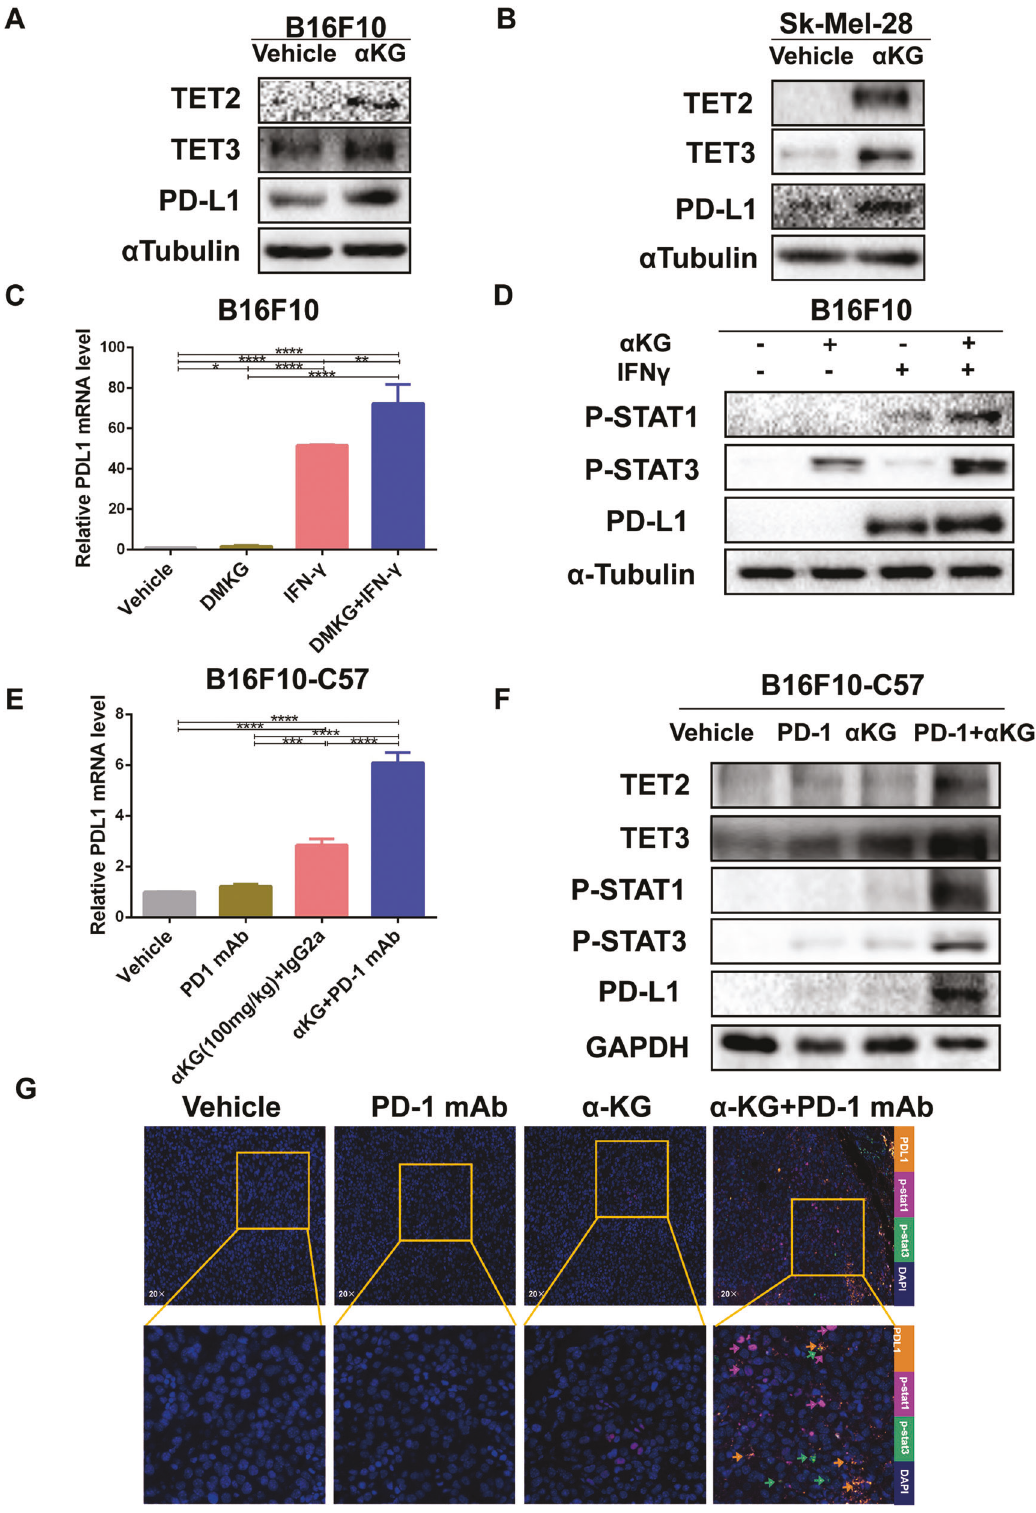
Fig. 5 α -ketoglutarate upregulated the expression of TET2/3 and IFN γ -induced STAT1/3 and PD-L1 in melanoma cells. A , B Cell lysates were extracted from B16F10 A and Sk-Mel-28 B cells, and immunoblotting was then performed. C , D Extraction of mRNA and protein from treated melanoma cells, and qRT – PCR C and immunoblotting D were then performed. E , F Extraction of mRNA and protein from treated B16F10 tumor-bearing mouse tissues, and qRT-PCR E and immunoblotting F were then performed. G Detection of the expression of p-STAT1/3 and PD-L1 in B16F10 tumor-bearing mouse tissues by TSA- fl uorescent multiplex immuno fl uorescence staining after the indicated treatments. Multiple experimental data ( n = 3) are counted and presented according to the statistical methods, and an asterisk (*) indicates the degree of signi fi cant difference.